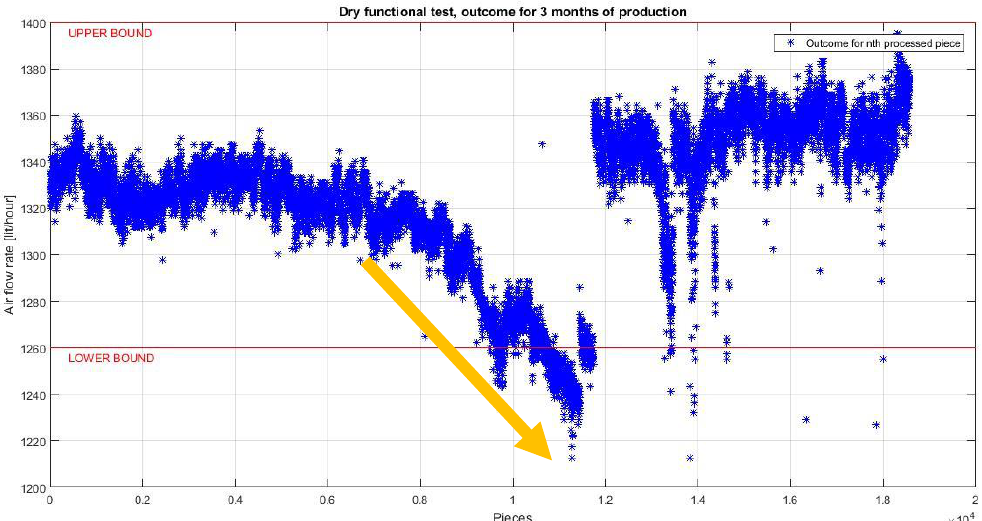
Figure 7. Time series of measured air flow rate. The degradation of an o-ring, a round gasket aimed at preserve air leakages, generates a decreasing path until the lower acceptable bound trespasses and the station starts discharging products. Each point represents a processed